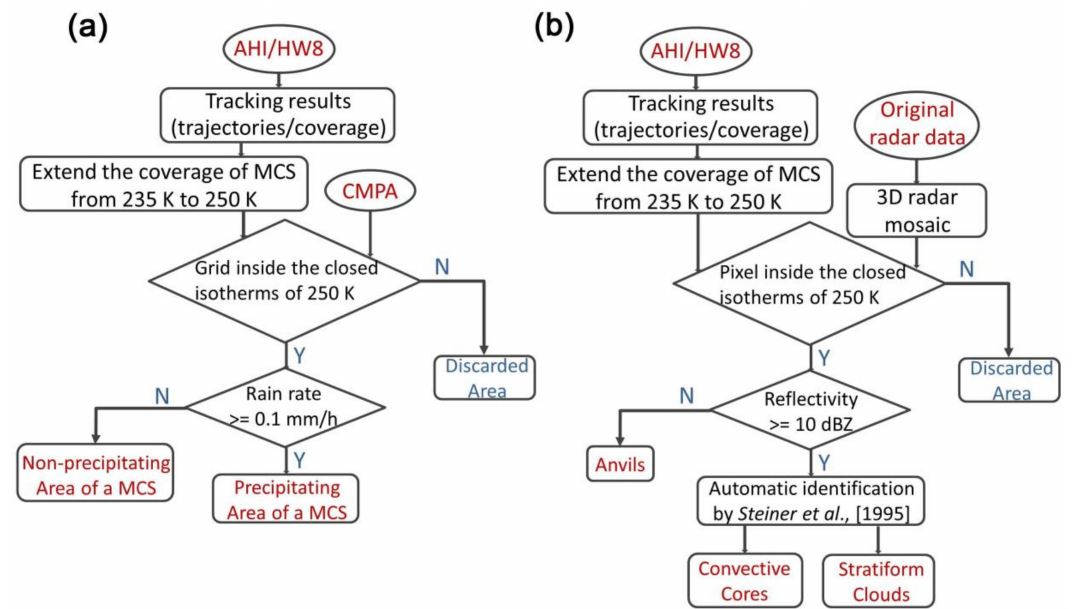
Figure 2. Flow chart showing ( a ) how to judge precipitating / non-precipitating area of a mesoscale convective system (MCS), and ( b ) how to identify di ff erent internal structures (i.e., convective cores, stratiform clouds and anvils) of an